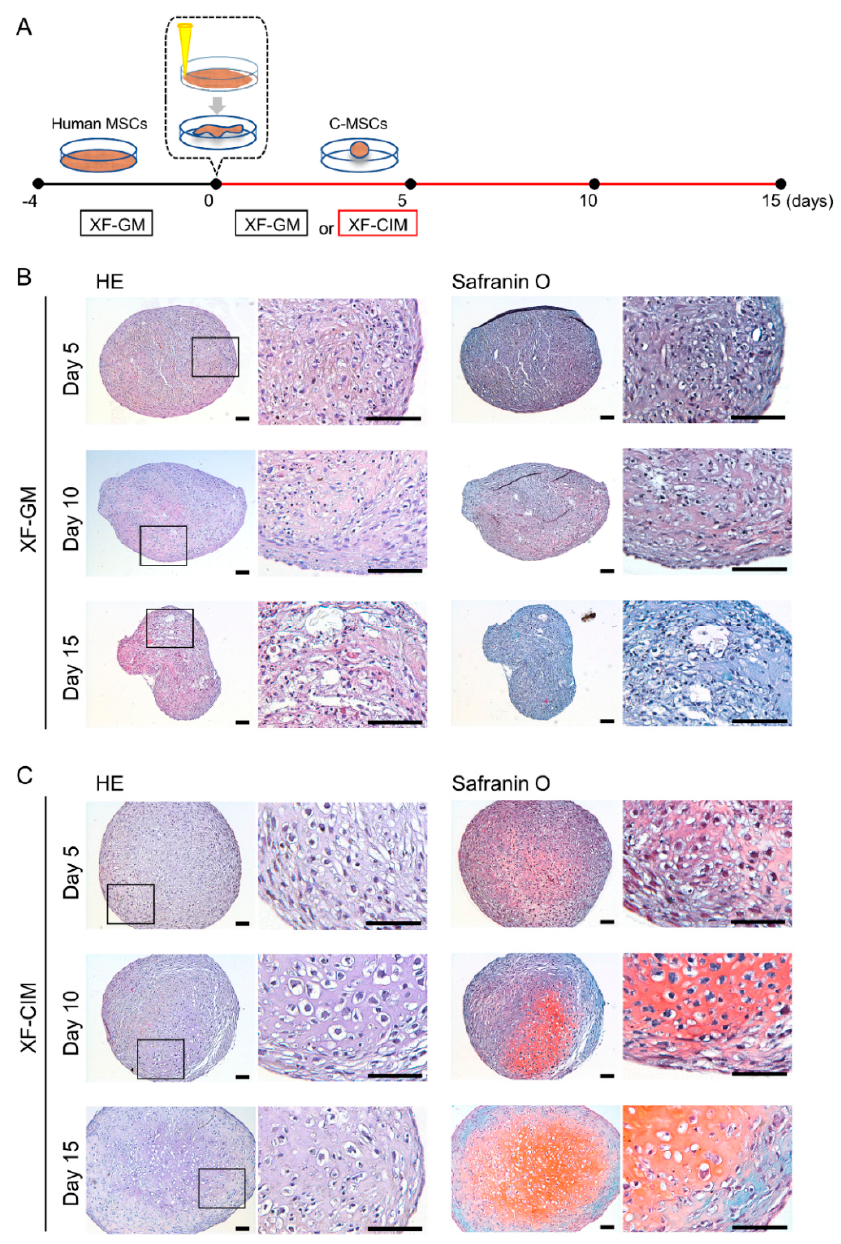
Figure 1. C-MSCs generated with xeno-free chondro-inductive medium show cartilaginous tissue. ( A ) Schematic figure of C-MSCs generation. (Figure 1B,C) C-MSCs were generated and maintained in XF-GM ( B ) or XF- CIM ( C ) for 5, 10, or 15 days as indicated. Semi-serial sections (8 µ m) were stained with HE or safranin O/fast green, respectively. The left panels show lower magnification and magnified images in the boxed regions are indicated in the right panels. Bar = 100 µ